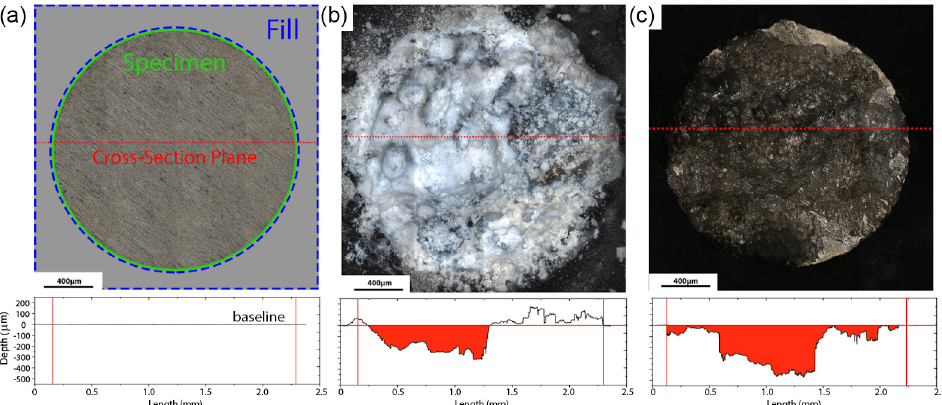
Figure 5. Panoramic images of the sample surface obtained using CLSM and methods for determining the volume of metal lost as a result of corrosion: before corrosion tests ( a ), after holding in Ringer’s solution ( b ), after removal of corrosion products ( c ) [183].